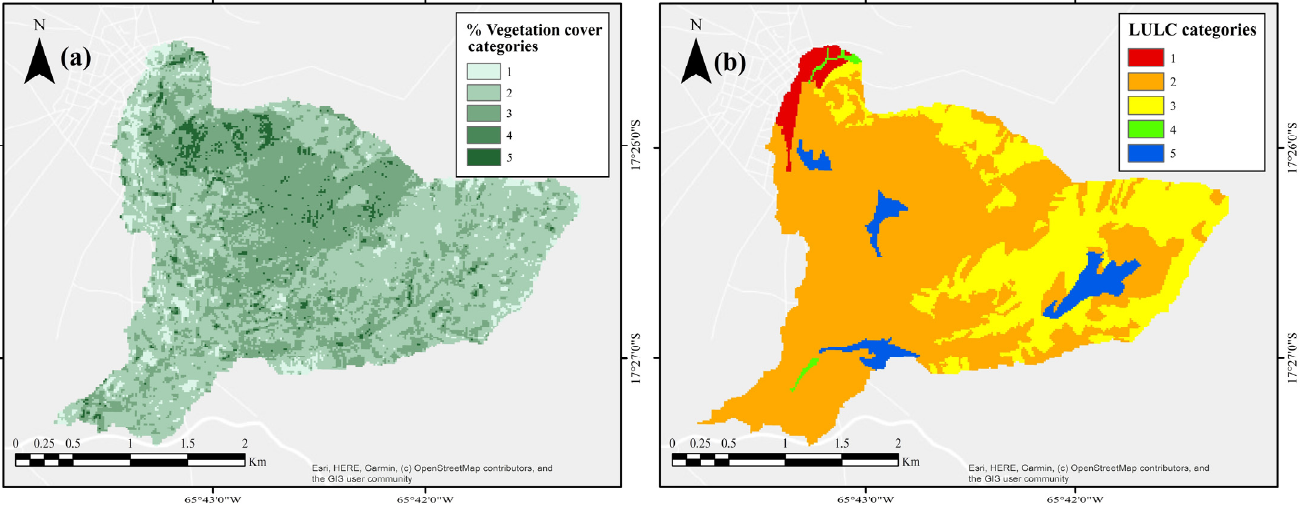
Figure 9. Reclassi fi ed maps of ( a ) the percentage of vegetation coverage in the Virvini basin and ( b ) land use and land cover categories. ( b ) land use and land cover categories.